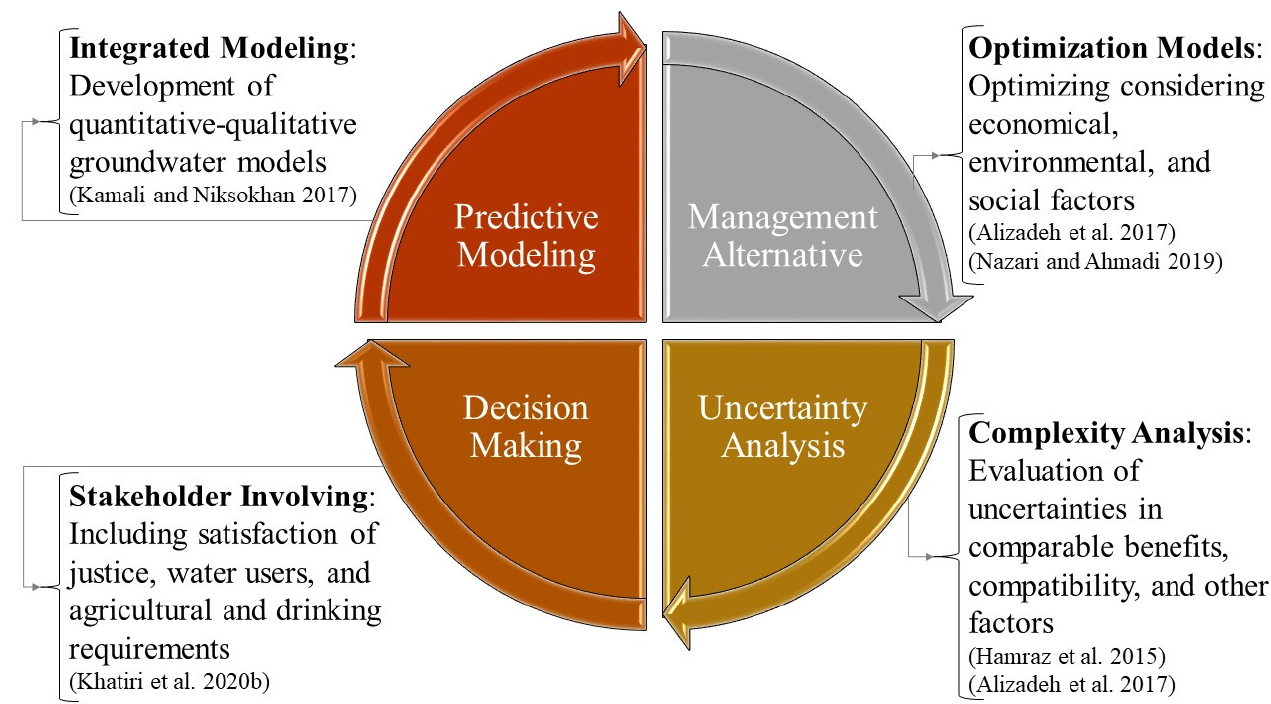
Figure 1. Interacting sectors of groundwater management [12–15].